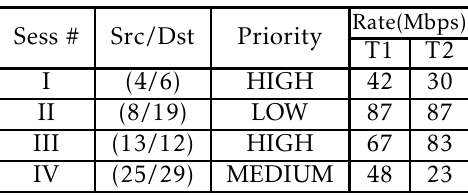
Figure 2. The routing path and link scheduling in two adjacent timeslots: a) timeslot 1, b) timeslot 2. Table 2. Detailed session information in Figure